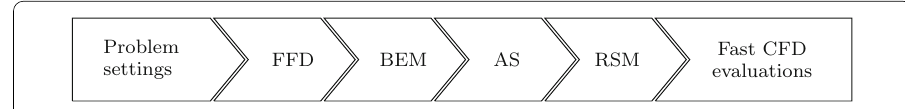
Fig. 1 Scheme of the structure of the pipeline proposed. The geometrical deformation is performed via free from deformation (FFD), then a boundary elements method (BEM) solver computes the wave resistance,